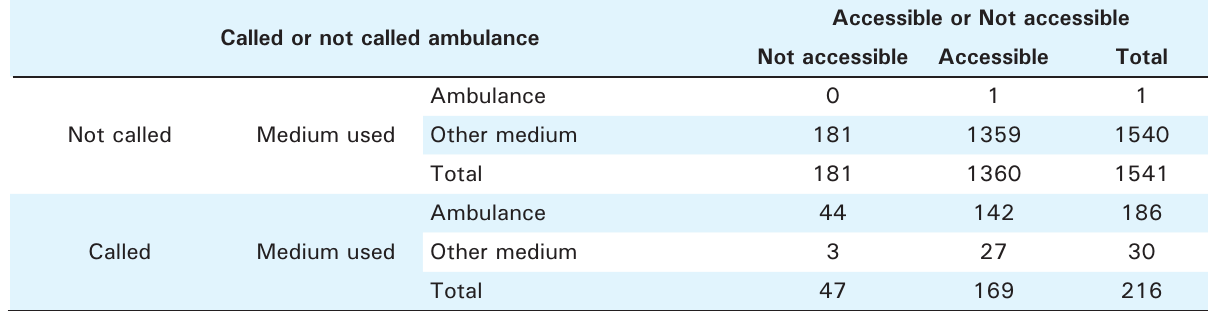
Table 4. PH ED patients by mode of transport and triage category